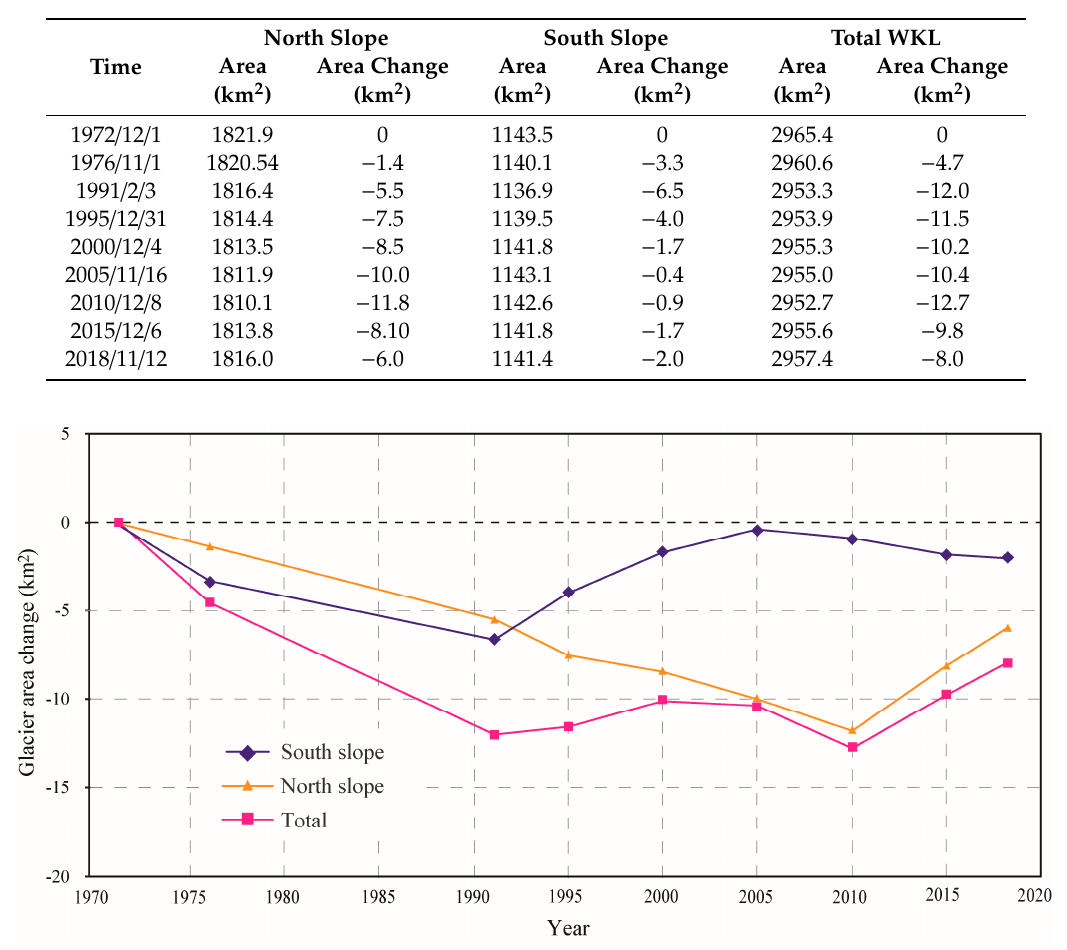
Figure 3. The glacier area changes on the south slope, north slope and for the total WKL. Table 2. Glacial area and changes from 1972 to 2018 in the WKL (the area change is based on the glacier area in 1972).